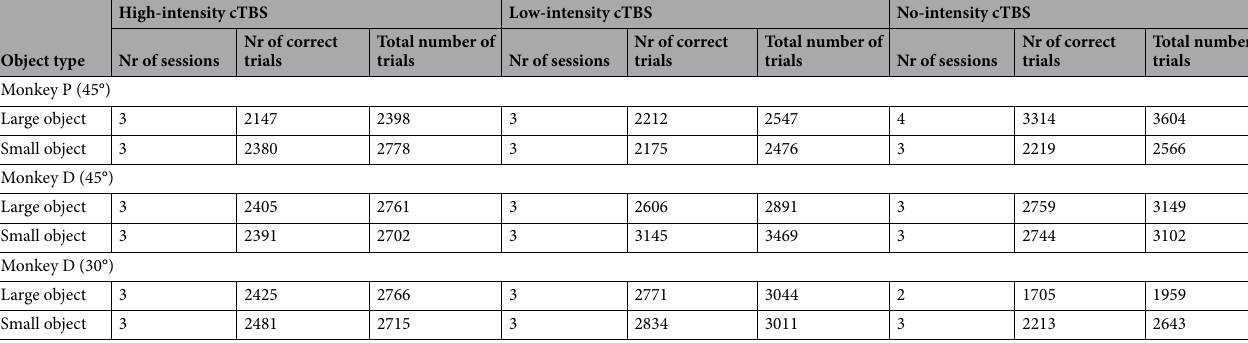
Table 2. Total number of sessions and correct trials collected for both the cTBS (monkey P & D, coil-angle at 45 degrees) and the control experiment (monkey D, coil-angle at 30 degrees). In these experiments, the monkeys were exposed to 6 different conditions: 2 grasping objects (large, small) × 3 stimulation conditions (high-, low- or no-intensity